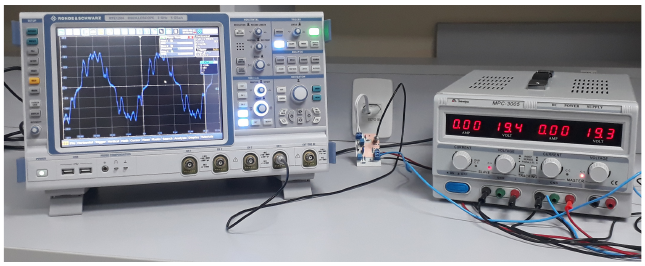
Figure 10. Measurement setup used to carry out Experiment #2.